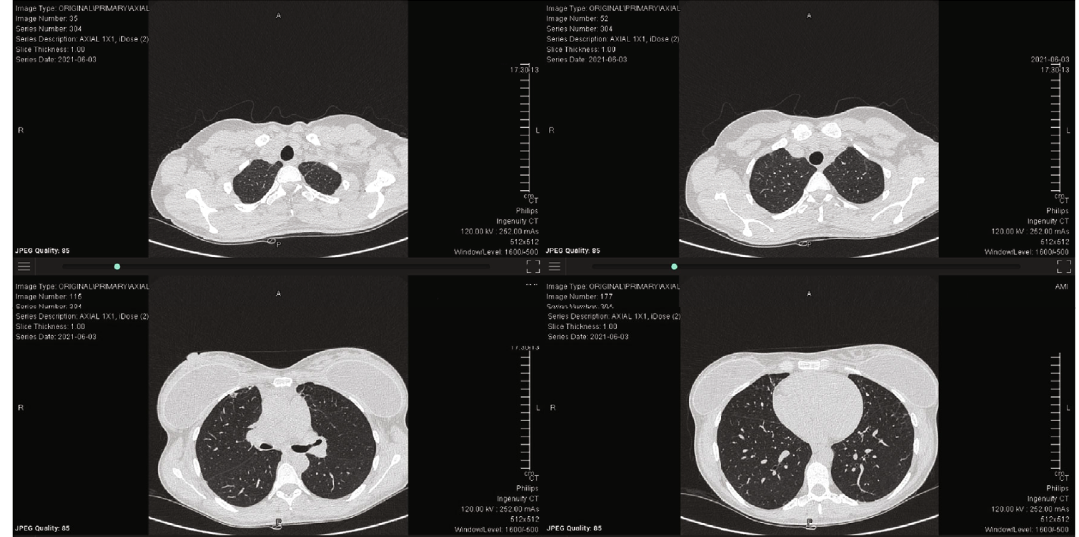
Figure 3: Resolution of disease seen on serial axial cuts of noncontrast chest CT six months after initial presentation.